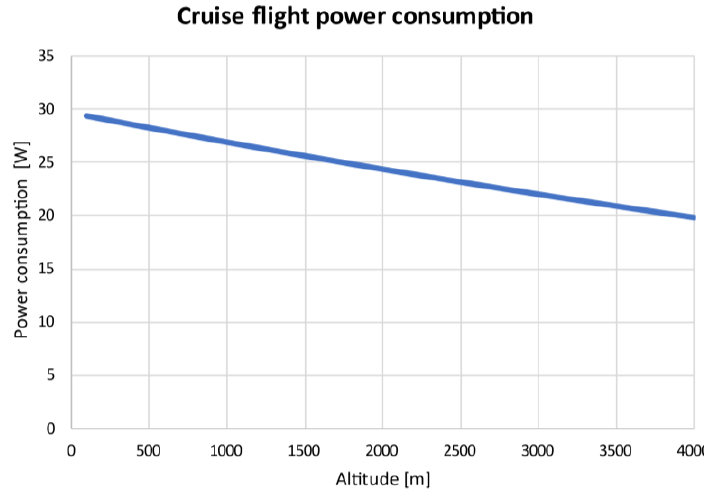
Figure 9. Power consumption during cruising for different altitudes.